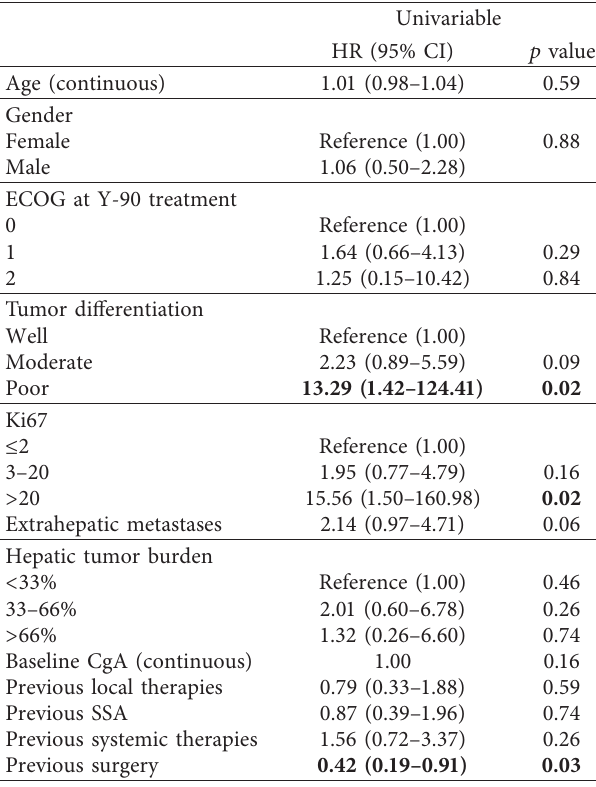
Table 3: Univariable analysis of factors associated with improved median overall